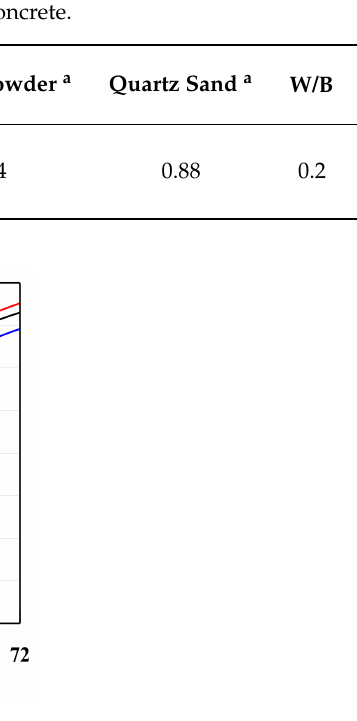
Figure 15. The cumulative heat test of the three different